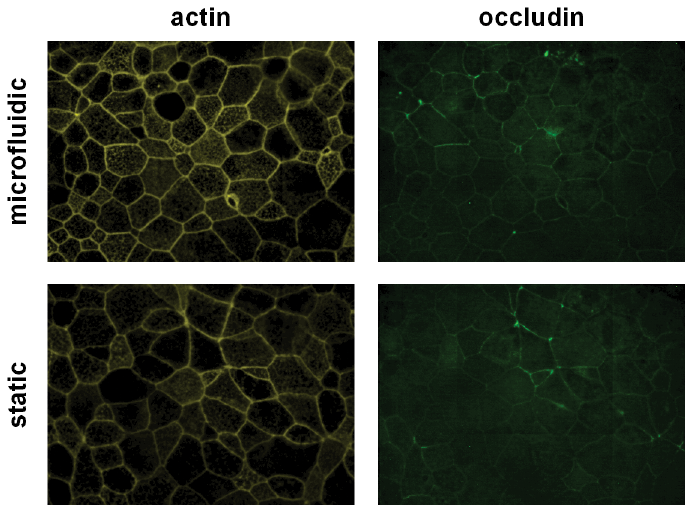
Fig 4. Cell viability and barrier integrity of differentiated PBECs in microfluidic compared to static culture conditions. After 24h in microfluidic or static culture conditions, actin filaments (yellow) and the tight junction protein occludin (green) were stained by immunofluorescence. Images are representative of 3 independent experiments using 3 different donors.